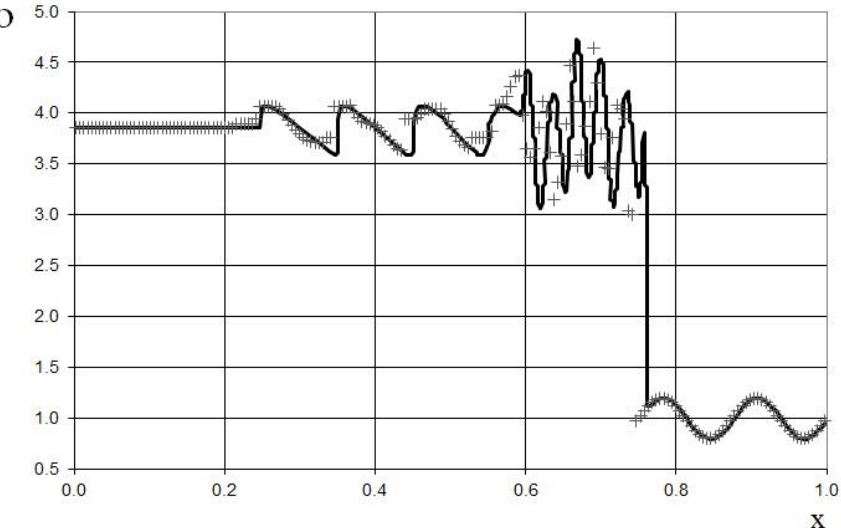
Figure 23. Density plot for the Shu–Osher shock-tube problem, using the coarse grid (192 grid points): the “exact” solution [44] (line), and the present method (cross).